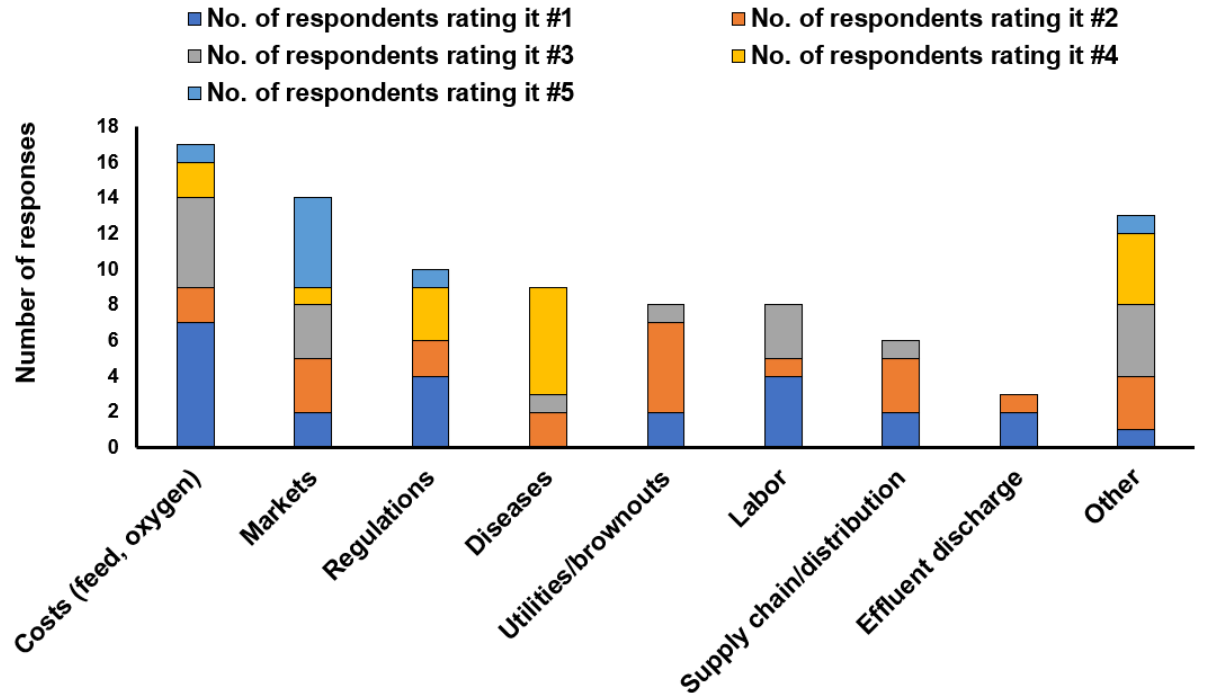
Figure 3. Producer responses to the following question: “We would like to put the importance of regulatory effects in the context of your overall business. What would you say are the top 5 biggest problems for your business? Please rank your top 5 problems with #1 being the biggest problem.” ( n = 24 respondents).